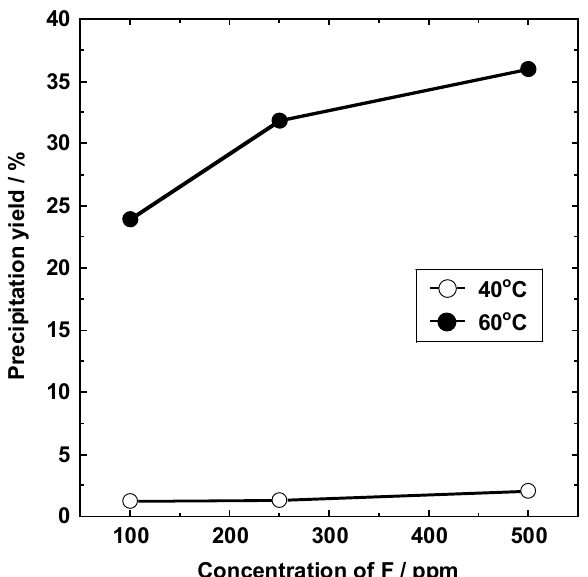
Figure 9. Relationships between solution fluorine concentration and precipitation yield.